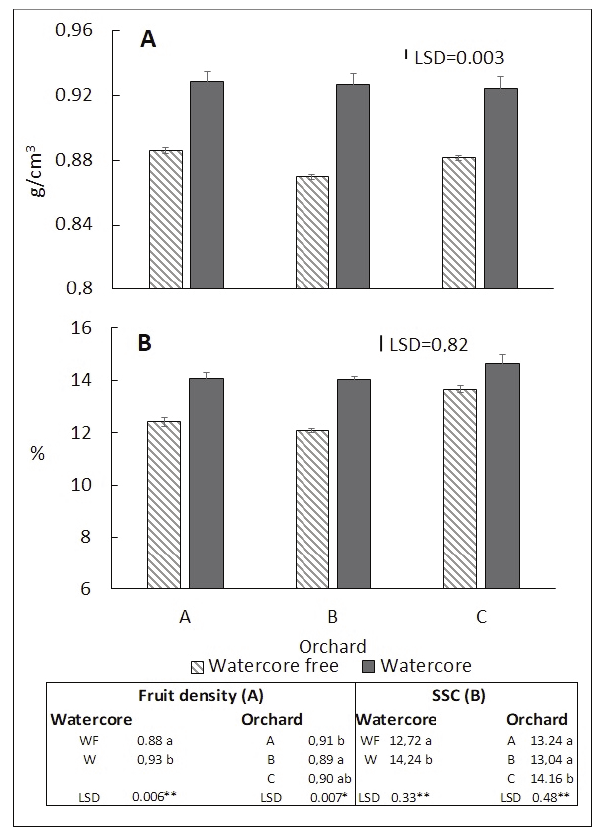
**Fig. 3 ­ Fruit density (A) and soluble solids content (B) of water­ core­free (WF) and watercore (W) fruit of ‘Pomella Genovese’ from three different orchards. Average ± stan­ dard error. LSD is reported in each figure (P>0.01). In the box at the bottom the average and LSD values are indica­ ted for each of the main factors (*=P<0.05;